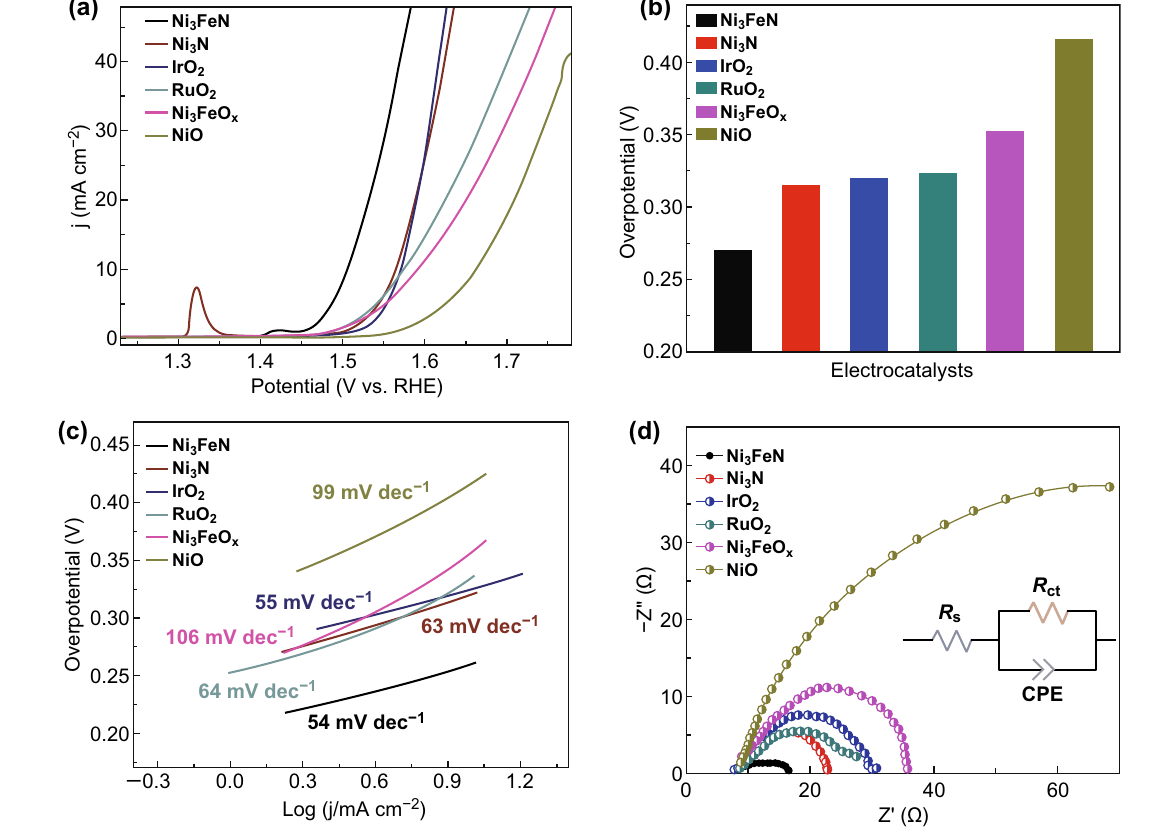
Fig. 4 a OER polarization curves in O 2 -saturated 1 M KOH (sweep rate: 5 mV s −1 ; rotation speed: 1600 rpm); b OER overpotentials at a cur- rent density of 10 mA cm –2 , c Tafel plots, d Nyquist plots obtained at 270 mV overpotential on NiO, Ni 3 Fe mixed oxide, IrO 2 , RuO 2 , Ni 3 N, and Ni 3 FeN (inset shows the equivalent